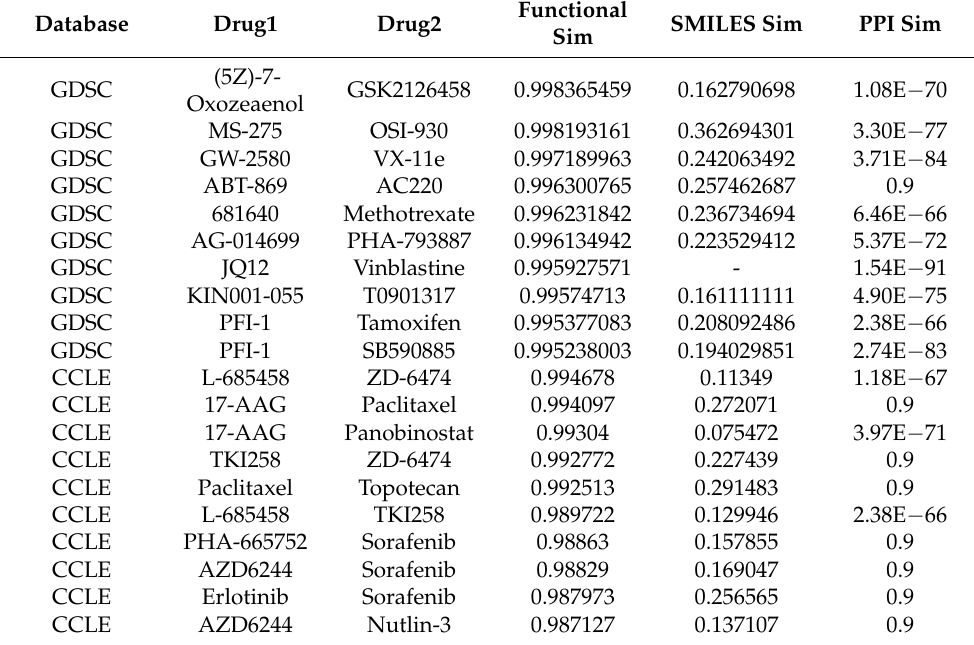
Table 2. Top 10 drug pairs’ similarities in GDSC and CCLE